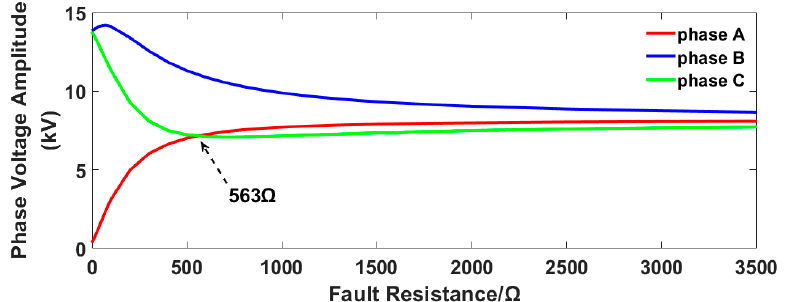
Figure 3. Changes in the voltage amplitude of three phases: A, B and C with fault resistance.